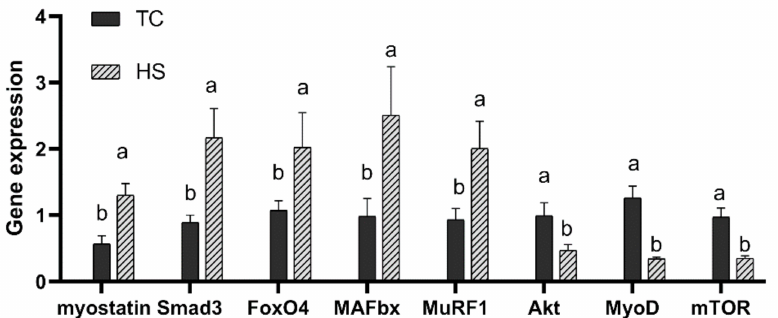
Figure 4. Effects of heat stress on the mRNA expression of breast muscle growth-related regulatory factors in broilers. TC, thermoneutral control group; HS, heat stress group. Each bar presents the means ± SD ( n = 6). a,b Values with different superscripts differ significantly at p < 0.05. FoxO4 = fork- head box O 4; MAFbx = muscle atrophy F-box; MuRF1 = muscle ring-finger 1; Akt = protein kinase B; MyoD = myogenic determination factor 1; mTOR = mammalian target of